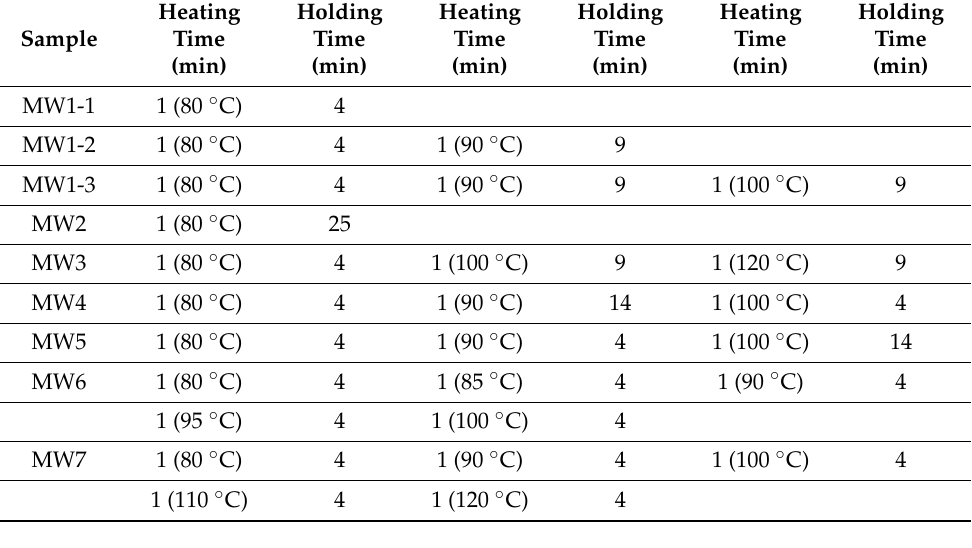
Table 1. The different temperature programming steps (including heating time, reaction temperature, and holding time).